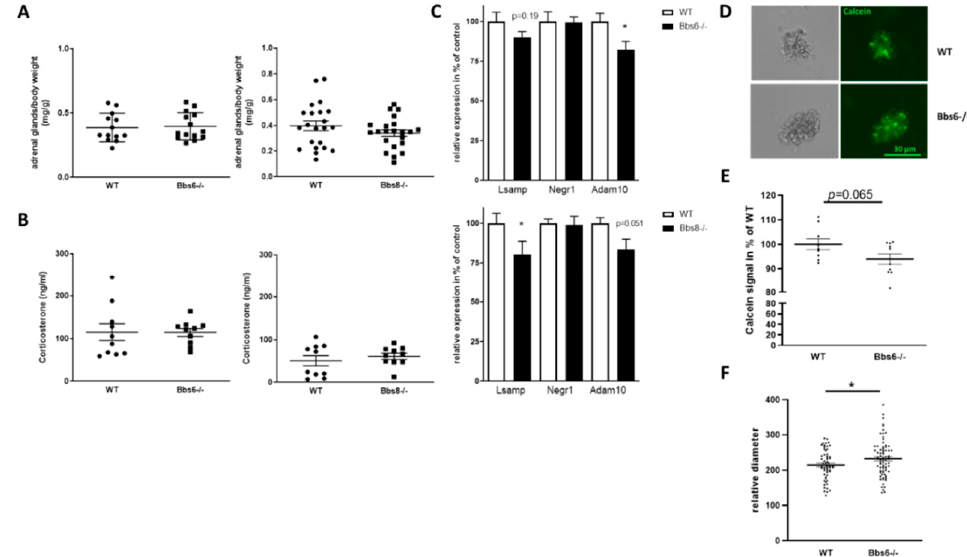
Figure 7. Effects on primary cilia defects on HPA axis. ( A ) Adrenal glands were weight pairwise during dissection and normalized to body weight ( n = 13 for WT and n = 14 for Bbs6 − / − ; n = 22 for WT and Bbs8 − / − ). ( B ) Corticosterone was measured by HPLC in serum samples ( n = 10 for all groups). Student’s unpaired t-test was used for statistical analysis. ( C ) Expression of IgLON members and Adam10 in the hypothalamus, analyzed by qRT-PCR ( n = 5-6 for WT and for Bbs6 − / − ; n = 5–6 for WT and Bbs8 − / − ). ( D ) Hypothalamic neurospheres of 10–12-week-old animals were cultivated up to day seven in vitro ( n = 3 for wild type; n = 4 for Bbs6 − / − ). Three wells per animal were stained by Calcein to demonstrate viability of the cell aggregates. Exemplary images are shown. ( E ) Fluorescence intensity was measured in lysates of the neurosphere cultures and normalized to the mean value obtained from wild type animals. ( F ) The horizontal diameter of randomly chosen neurospheres was assessed by ImageJ. Student’s unpaired t -test was used for statistical analysis ( n = 5–6 animals per group; * p < 0.05).